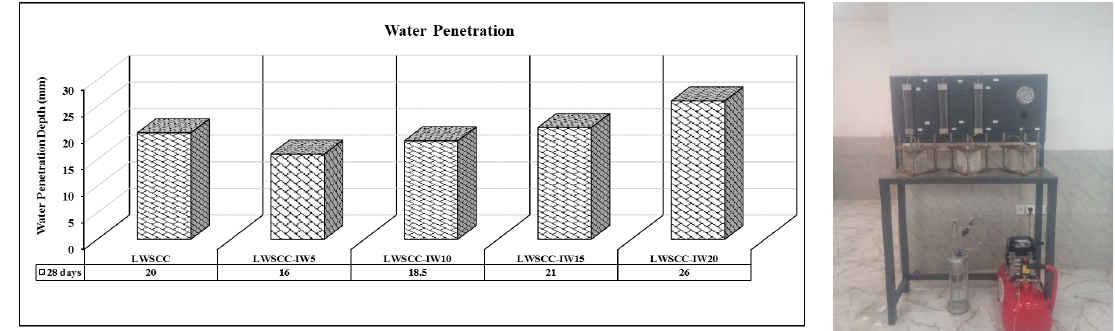
Figure 6 . Water penetration depth of LWSCCs containing SMIW at 28 days